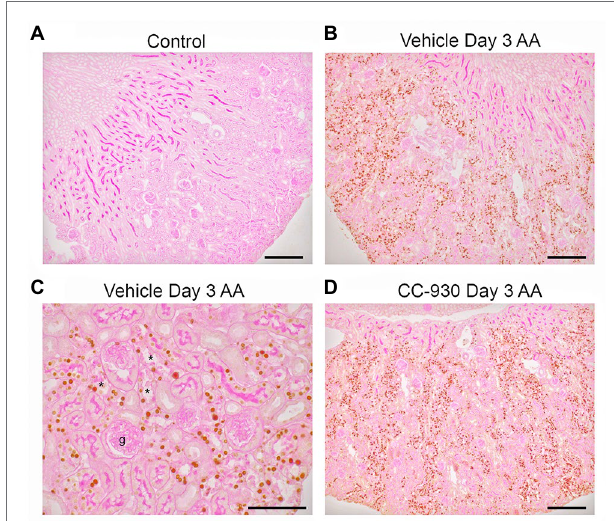
FIGURE 2 | Immunostaining for the DNA damage marker, phospho-Histone 2A.X Ser 139 , on day 3 of AA-induced acute kidney injury. (A) No staining is seen the normal control kidney. (B) Many tubular nuclei show p-H2A.X staining in the cortex in vehicle treated day 3 AA. (C) High power view of vehicle treated day 3 AA shows staining in both damaged (*) and intact tubules, but no staining is seen in the glomerular tuft (g). (D) A similar pattern of stained for p-H2A.X in tubular nuclei is seen in CC-930 treated day 3 AA. Sections have PAS counterstain. Bars represent 200 μ m (A,B,D) , or 100 μ m (C) .